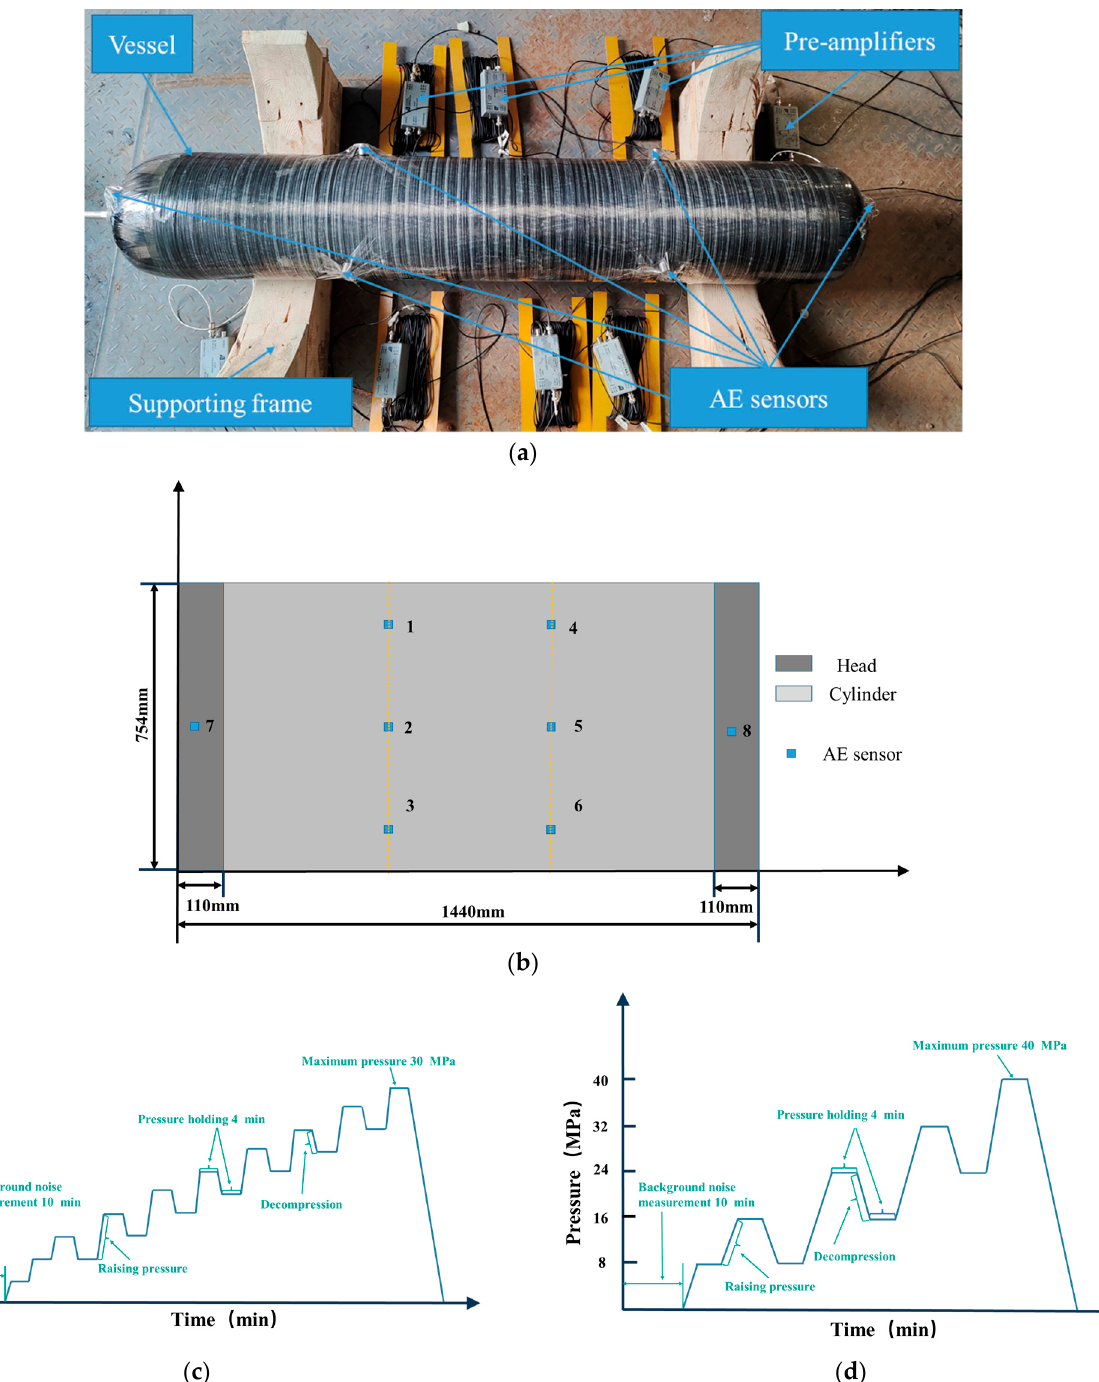
Figure 3. System connection of experimental device for the pressure vessel pressurization test ( a ), sensor layout diagram on the vessel ( b ), hydraulic time loading curve of pressure vessel in 1.5 working pressure ( c ), and 2 working pressure ( d ).